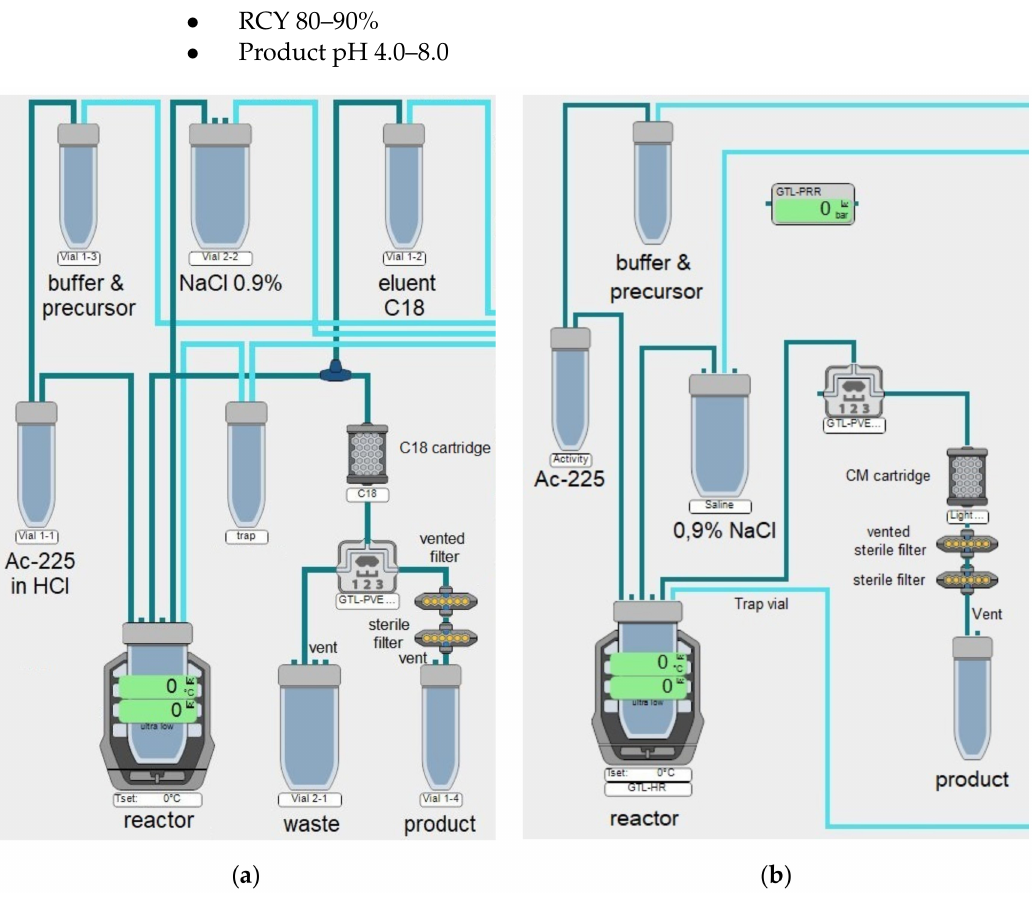
Figure 1. A schematic depiction of the synthesis scheme of the Modular-Lab EAZY module: ( a ) the C18 method; ( b ) the CM